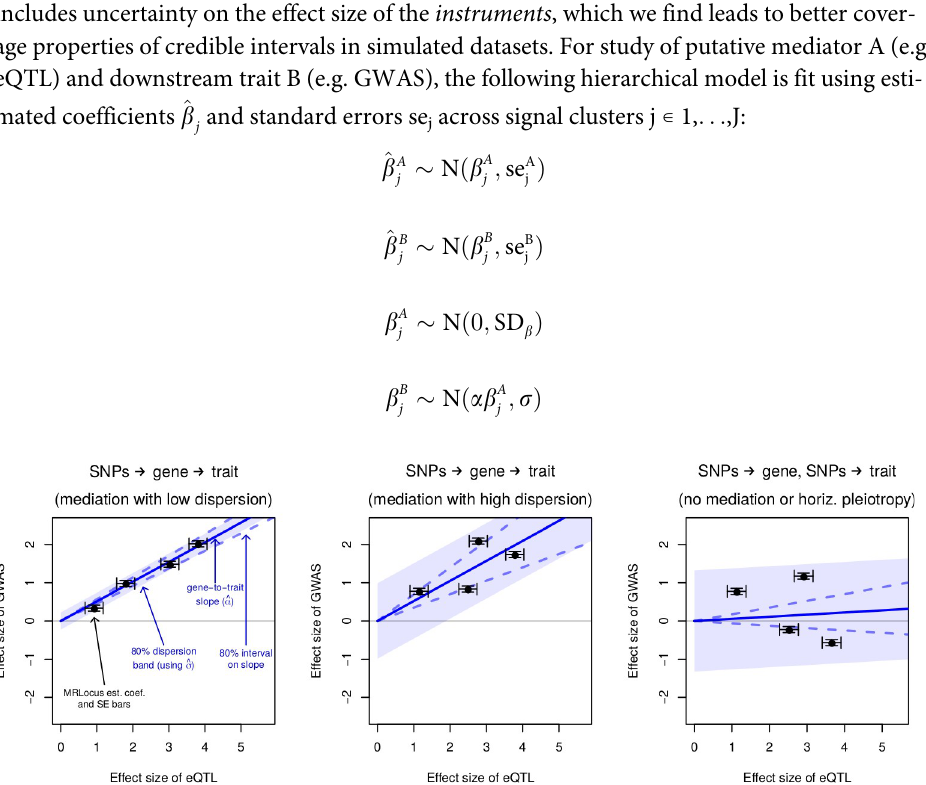
Fig 1. MRLocus estimates the gene-to-trait effect (solid blue line) as the slope from paired eQTL and GWAS effect sizes from independent signal clusters (black points with standard error bars), here on simulated coefficients. The dispersion of allelic effects around the main gene-to-trait effect (light blue band) is also estimated. An 80% credible interval on the slope is indicated with dashed blue lines sloping above and below the solid blue line. Panels represent loci demonstrating (A) mediation with low dispersion, (B) mediation with high dispersion, and (C) colocalization of eQTL and GWAS signals but no evidence of mediation (slope credible interval overlaps 0). Investigators may wish to prioritize loci for experimental follow-up in which a typical “dosage” pattern is observed, such that alleles contributing small amounts to expression of a gene contribute small amounts to GWAS trait, and similarly for large effect alleles.